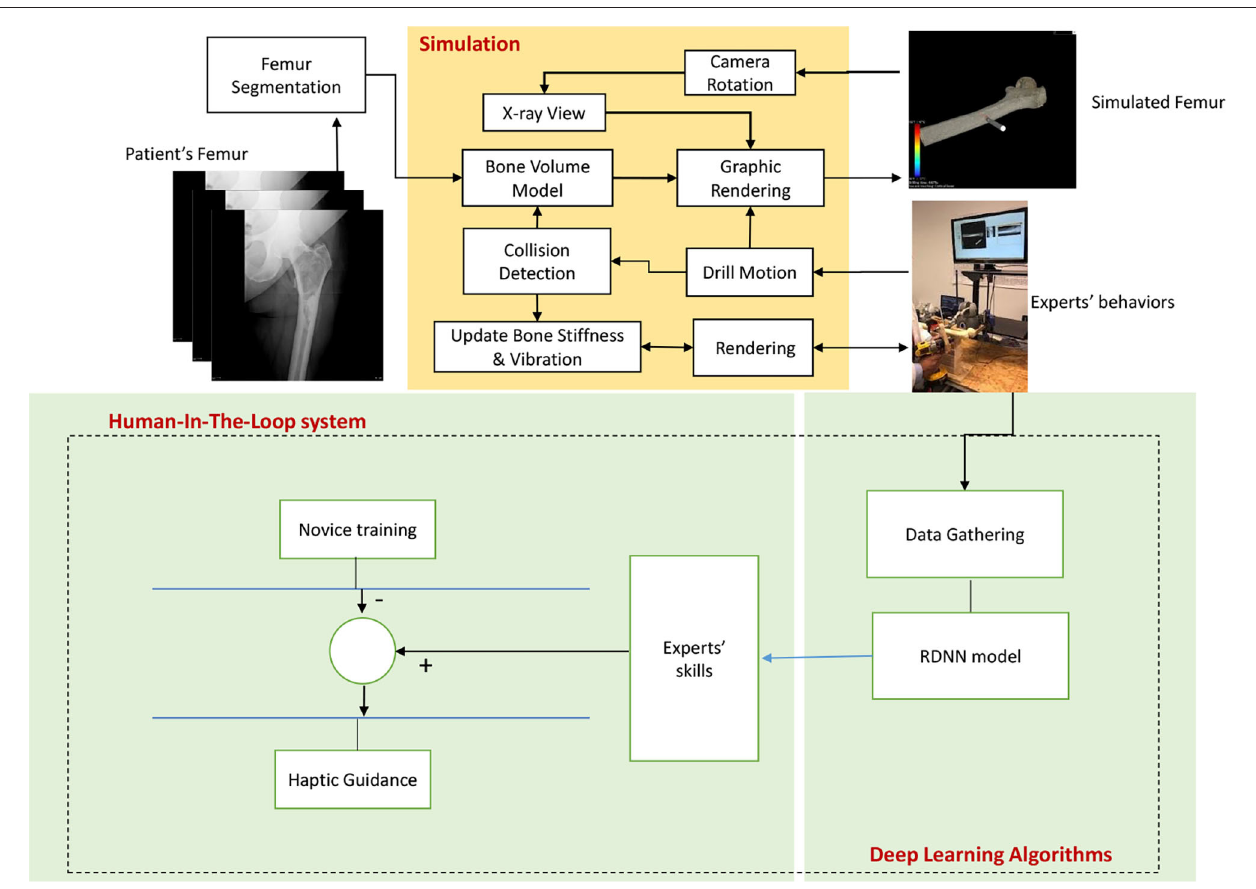
FIGURE 1 | The diagram depicts the structure of the Deep Haptic Guidance (DHG). The CT data corresponding to a patient enters for modeling, rendering, and determining the stiffness of the bone. The data are captured while an expert is completing the task. The obtained data are converted to a compatible dataset for training deep recurrent neural network. The trained model provides haptic force feedback based on the professional demonstrations. The guidance signal is generated by the difference between the DHG’s prediction and force feedback of novice user. In fact, expert’s skill implies DHG’s